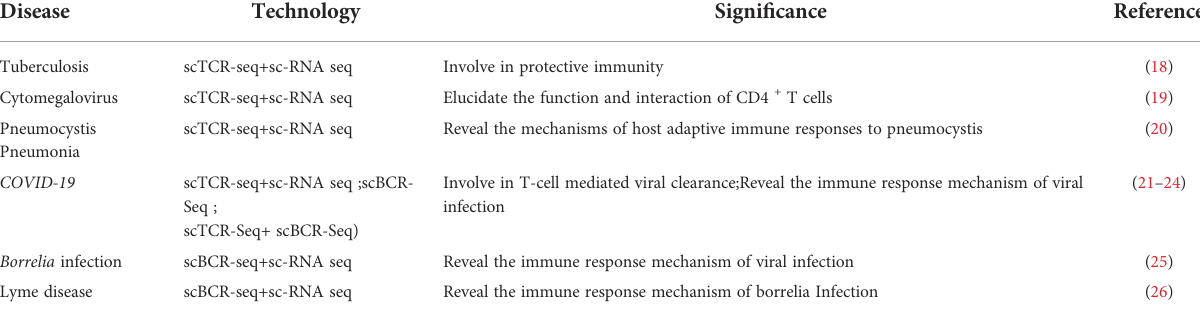
TABLE 2 Summary of the application of single-cell TCR/BCR sequencing technology in infectious diseases.